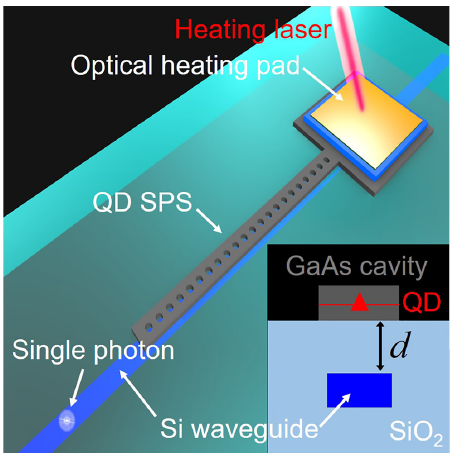
Figure 11. Schematic of the investigated device structure. A QD SPS is placed above a glass-cladded silicon waveguide. An optical heating pad is implemented on the marginal region of the integrated SPS (inset: schematic of the device cross-section). Reprinted (adapted) with permission from Ref. [53]. Copyright (2020) AIP Publishing.